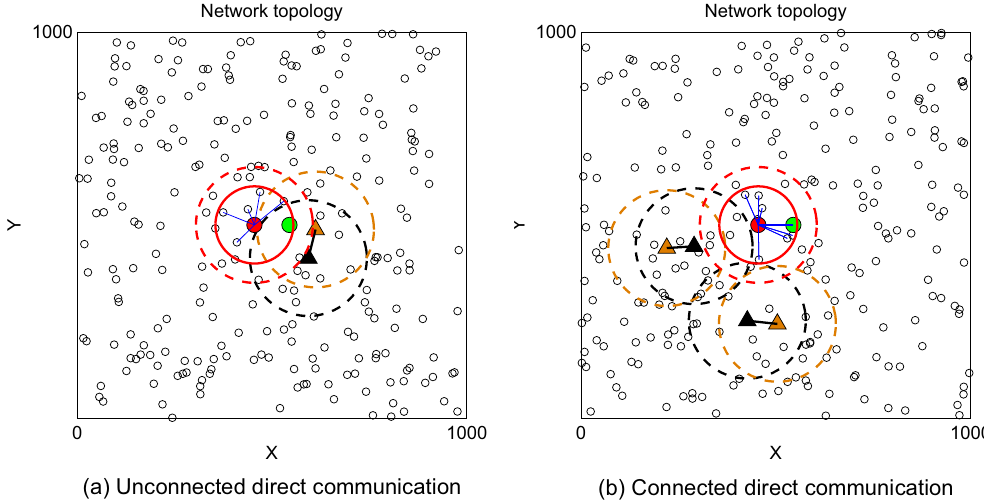
Figure 7. Illustration of direct communication between two SUs. a = 1000 m, N S = 250, N P = 5, λ P = 0.5, R T = r T = 100 m, R I = r I = 150